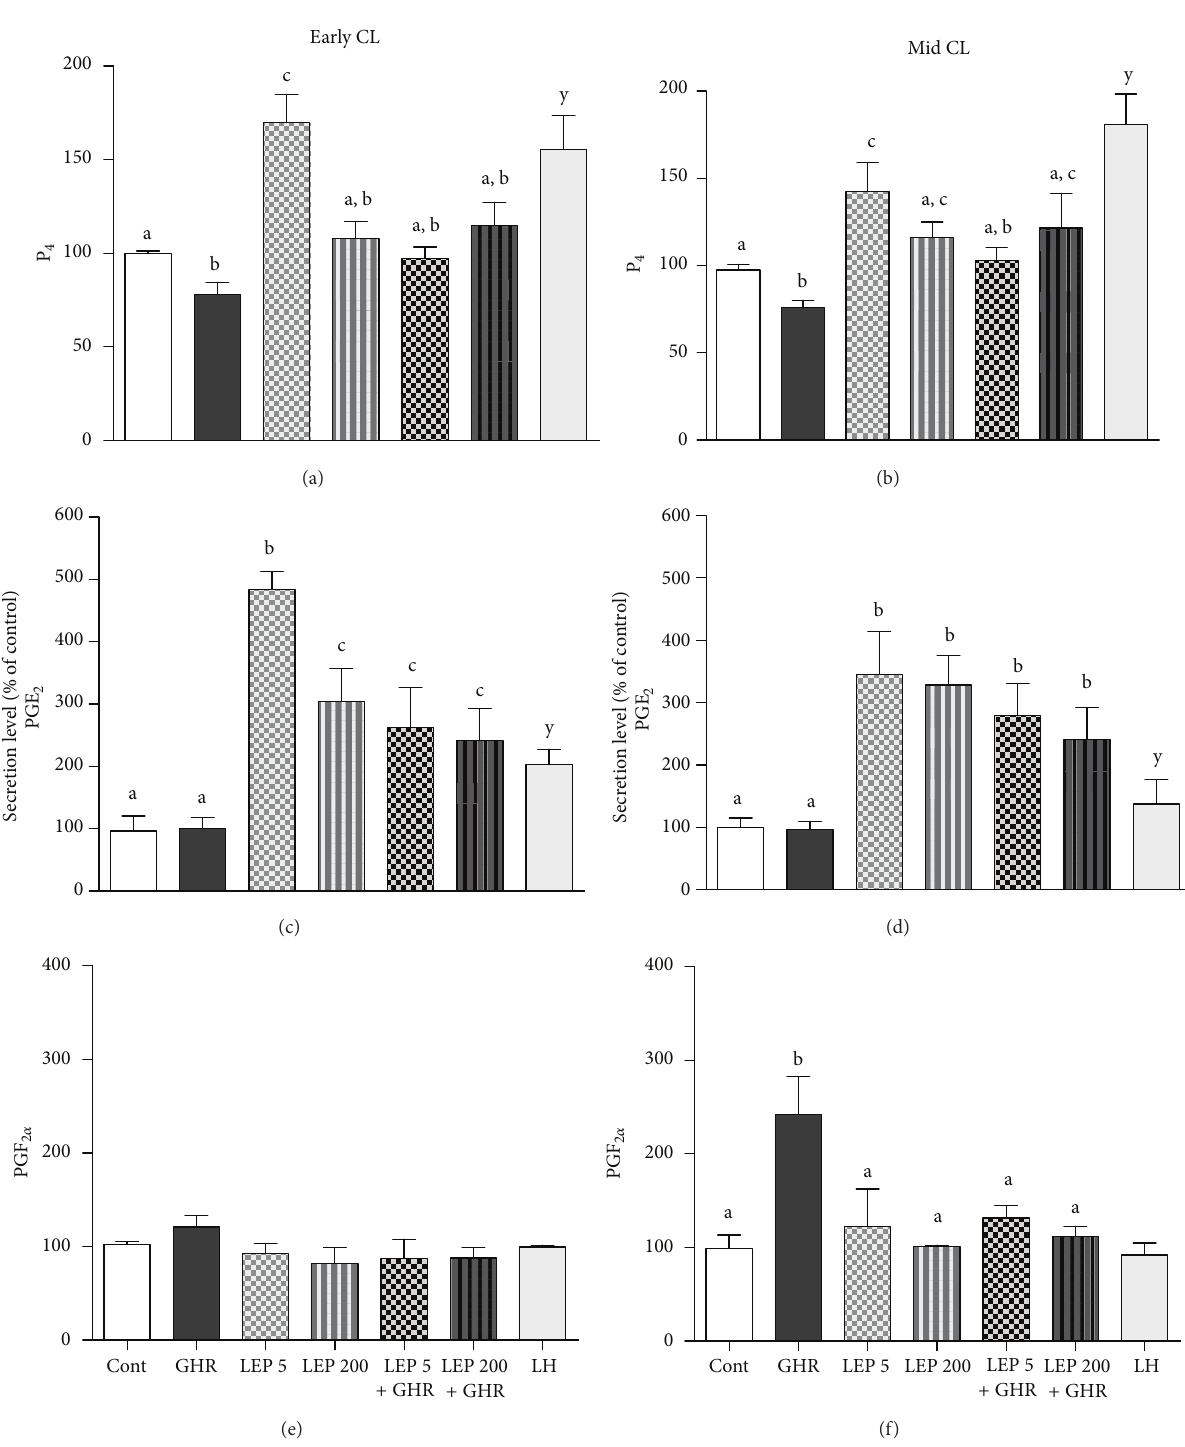
Figure 4: Early CL and mid-CL explants in vitro production of P 4 ((a) and (b)); PGE 2 ((c) and (d)); and PGF 2𝛼 ((e) and (f)), after 24 h treatmentwithnoexogenousfactor=ControlorwithGHR(50 ng/mL),LEP(5ng/mL),LEP(200ng/mL),LEP(5ng/mL)+GHR(50ng/mL), LEP (200 ng/mL) + GHR (50 ng/mL), or LH (positive control; 10ng/mL). Bars represent mean ± SEM. Different letters indicate significant differences ( ∗ 𝑃 < 0.05 ; ∗∗ 𝑃 < 0.01 ; ∗∗∗ 𝑃 < 0.001 ). Correspondent value of control for hormone production mean ± SEM: early CL P 4 ( 1.05 ± 0.031 ng/mg); mid-CL P 4 ( 6.305 ± 0.30 ng/mg) and for PGE 2 ( 0.23 ± 0.05 ng/mg) and PGF 2𝛼 ( 0.147 ± 0.015